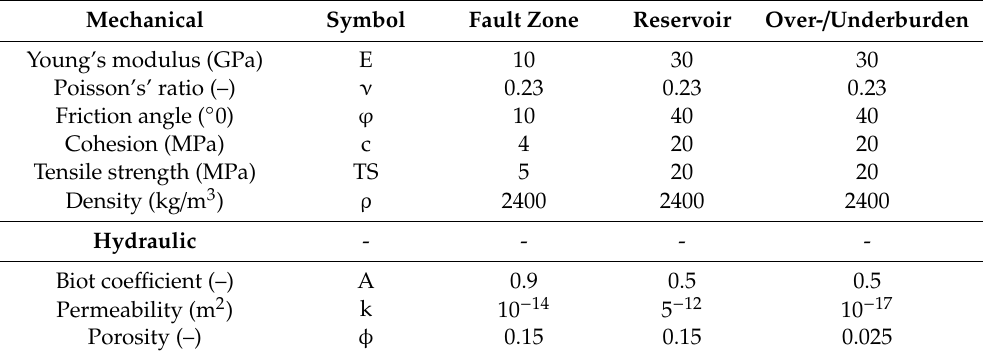
Table 2. Hydraulic and mechanical parameters used for the three model units. Mechanical Symbol Fault Zone Reservoir Over- /